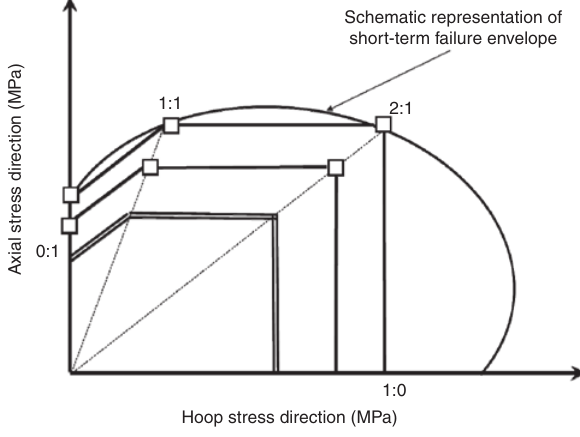
Figure 2: Failure envelope according to ISO 14692 [1, 2].